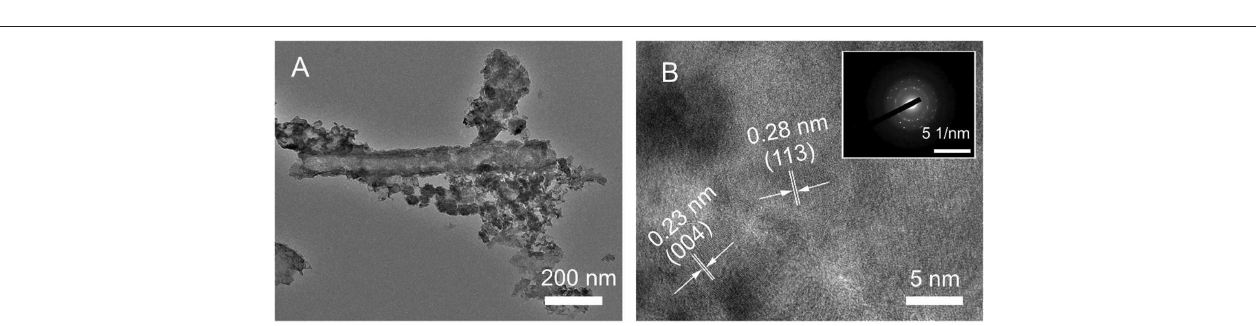
FIGURE 3 | TEM image (A) ; HRTEM image (B) ; and SAED pattern (inset) of CuCo 2 S 4 /CC.